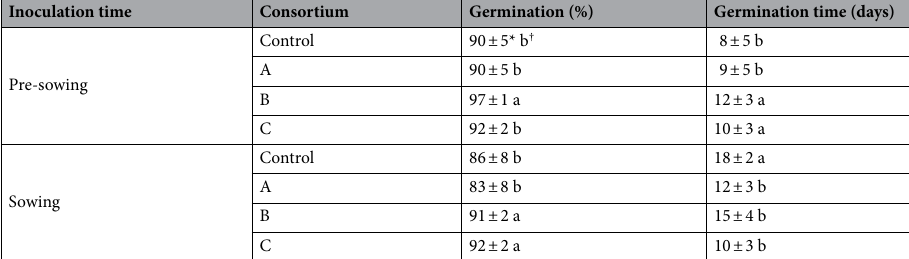
Table 3. Percentage and time of germination of tomato seeds inoculated with rhizobacterial consortia from C. longiscapa at presowing and sowing. *Values represent the means ± standard deviation of 50 seeds per treatment. † Different letter in each column denote significant differences ( P ≤ 0.05) by ANOVA followed by Tukey’s post-hoc test.